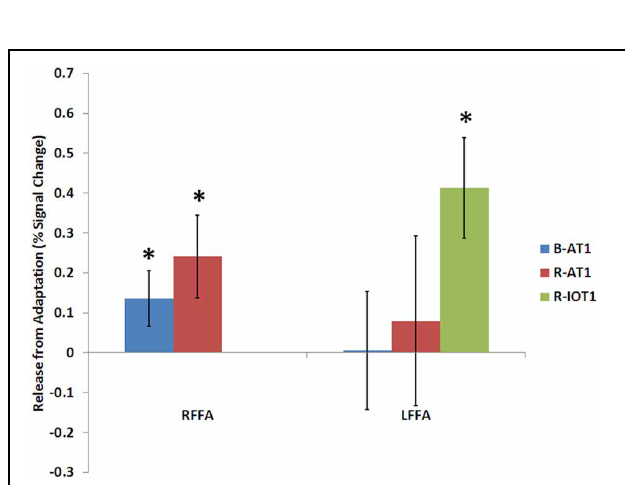
FIGURE 6 | Release from adaptation in response to identity changes as seen in the occipital face areas of the three patients. Significant release from adaptation was observed in the left FFA of all three patients and only in the right OFA of B-AT1 (R-IOT1 did not have a right OFA due to damage). ∗ p < 0 .